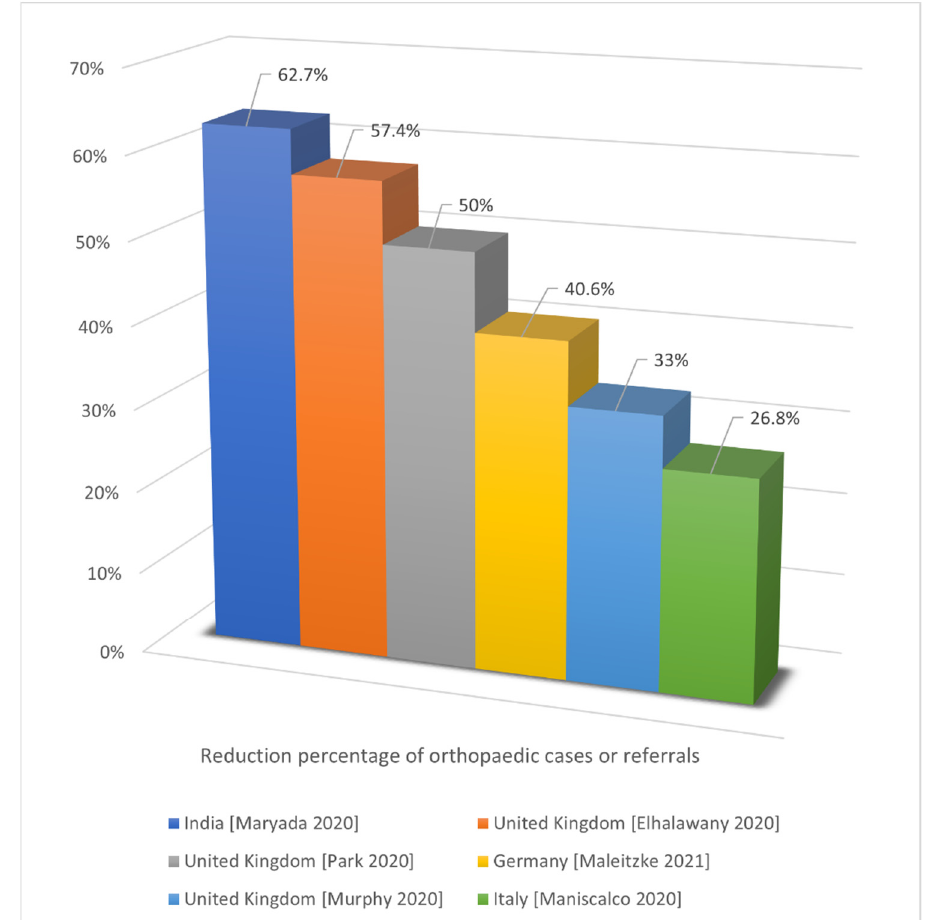
Figure 5. Reduction in orthopedic cases or